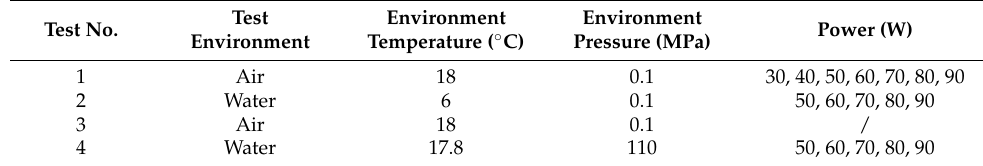
Figure 3. Air displacement characteristics test bench: ( a ) Schematic of air displacement characteristics testing system, and ( b ) air displacement characteristics test site. Table 2. Experimental conditions.